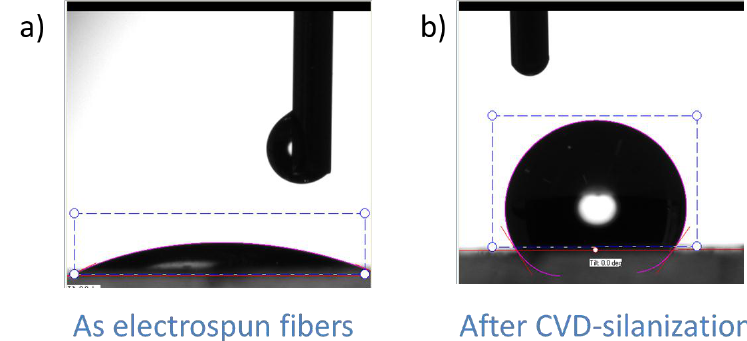
Figure 7. The variation of the water contact angle (WCA): ( a ) electrospun fibers composed of PAA + β-CD + TiO 2 NPs (hydrophilic behavior with a value of 23.95°); ( b ) electrospun fibers after the CVD-silanization process (hydrophobic behavior with a value of 125.80°).